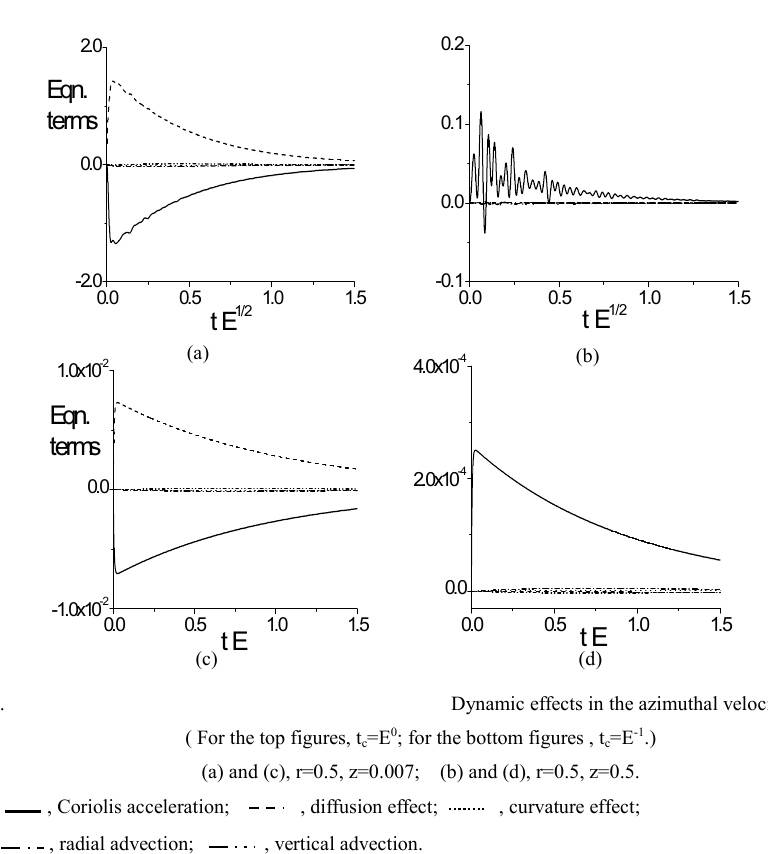
Fig 3. Dynamic effects in the azimuthal velocity equation. ( For the top figures, t c =E 0 ; for the bottom figures , t c =E -1 .) (a) and (c), r=0.5, z=0.007; (b) and (d), r=0.5, z=0.5. , Coriolis acceleration; , diffusion effect; , curvature effect; , radial advection; , vertical advection. three points are in the interior. The features of the classical spin-up are captured in Fig.